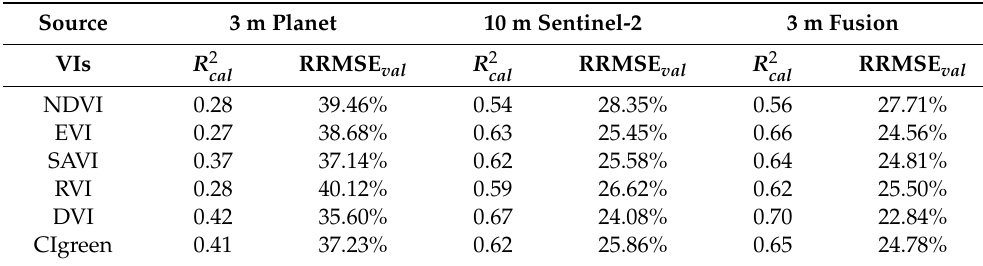
Table 5. Comparison of R 2 and RRMSE val values between none-RE-VIs and LAI estimates derived cal from Planet, Sentinel-2, and fused